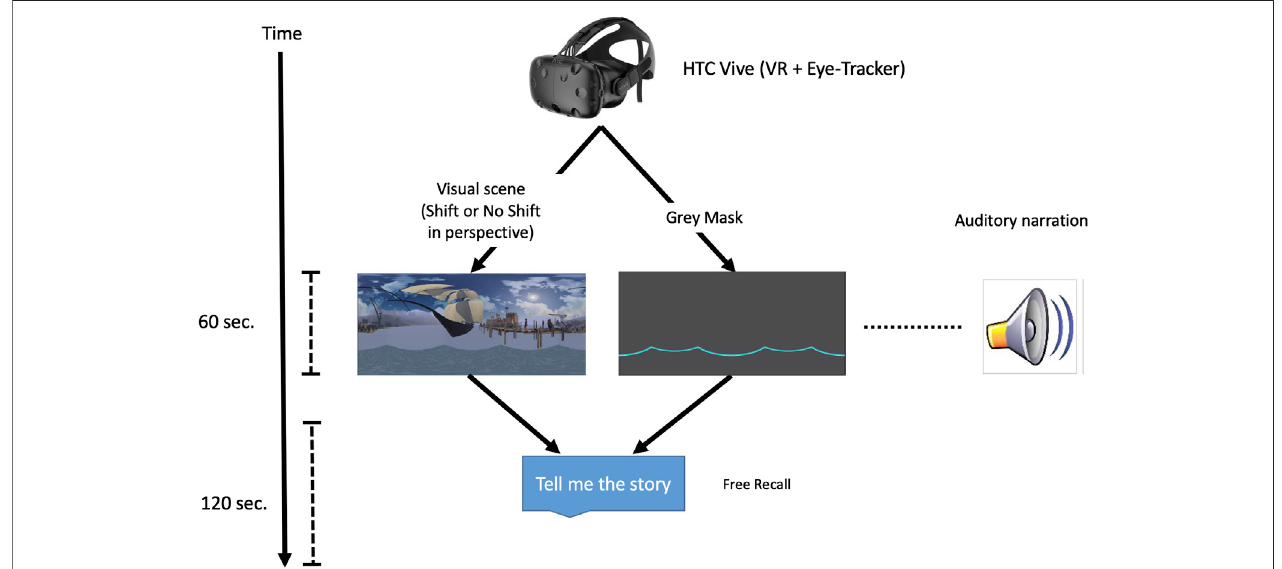
FIGURE 2 | Procedure: The participants received twelve experimental VR scenes/videos, crossing two audio condition (Shift/No Shift) and three visual conditions (Shift/No Shift/Grey mask). Each VR audio-visual narration (scene/video) lasted 60 s. After each trial, the participant received the message “ Tell me the story ” on the VR headset, and freely recalled orally for 120 s as much information as possible.